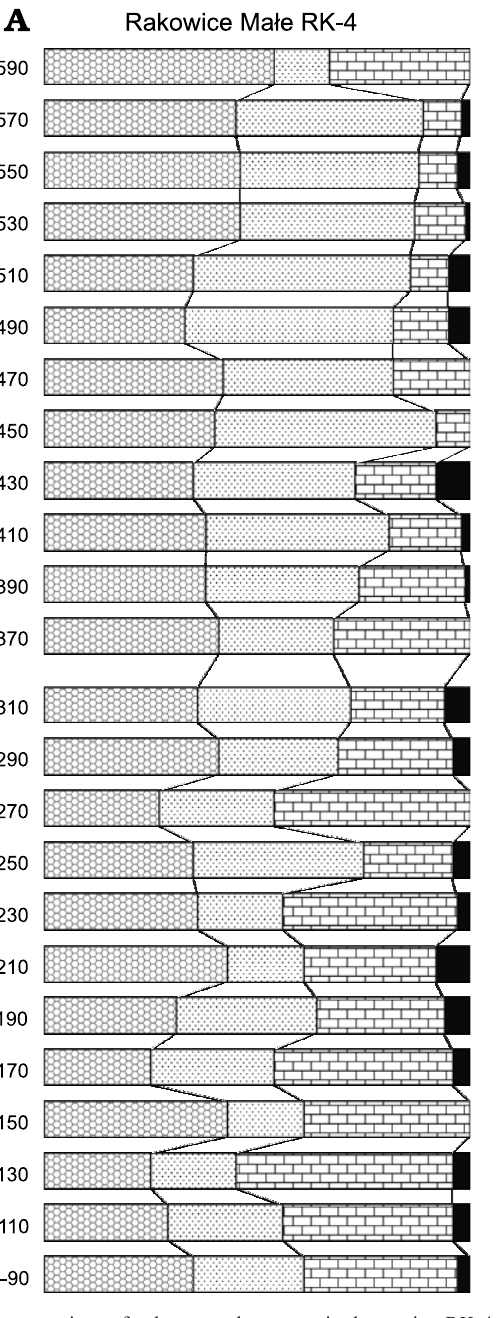
Fig. 20. Relative proportions of palynomorphs groups in the section RK-4, Rakowice Małe ( A ) and Żeliszów ( B ). Numbers on the left-hand side of the diagrams refer to distances (in cm) of samples from reference levels (see text for further